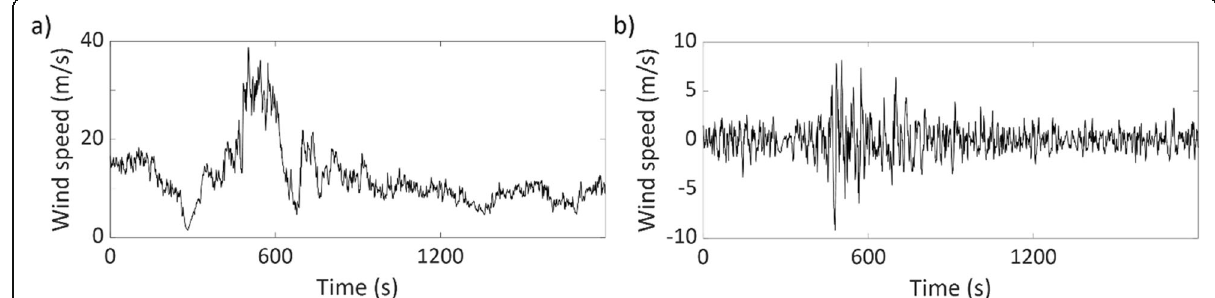
Fig. 5 Wind velocity record from Tower 4 and 10 m height of the rear-flank downdraft that occurred during the evening on June 4, 2002, near Lubbock, Texas [13, 34]: a the wind record, and b the fluctuating component of the record